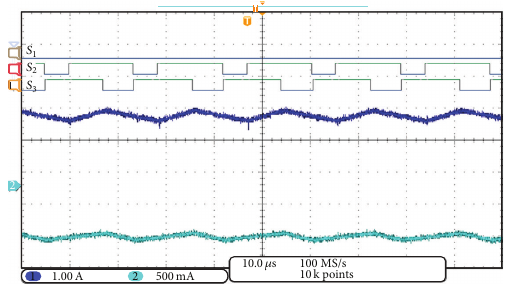
Figure 13: Operation when the battery set is being charged from top to bottom: 𝑆 1 , 𝑆 2 , 𝑆 3 , 𝐼 𝐿 inductors is the same.